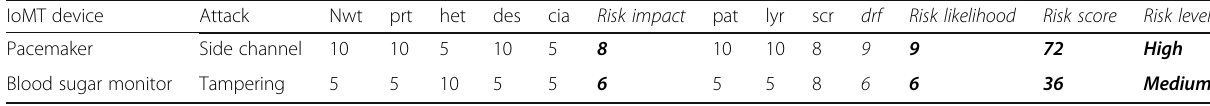
Table 8 IoMT real incident risk classification IoMT